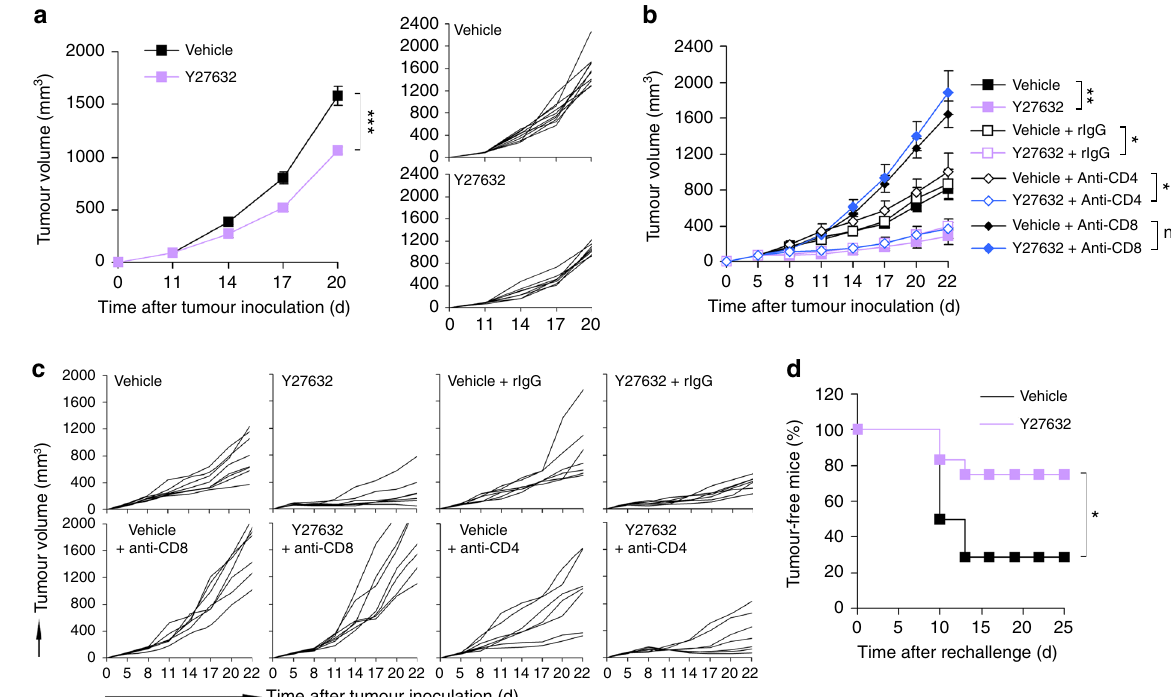
Fig. 3 ROCK blockade induces antitumour immunity. a CT26.CL25 tumour-bearing nude mice were injected (i.v.) with Y27632 (10 mg kg − 1 ) or vehicle. Tumour volume was measured at the indicated times. Data are presented as means ± s.e.m. (left panel) and tumour growth curves of individual mice (right panels) ( n = 8 – 10). b , c BALB/c mice were transplanted with CT26.CL25 cells and injected with Y27632 (10 mg kg − 1 ) at the indicated times, as described in Supplementary Fig. 6e. Five days after tumour inoculation, mice were injected (i.p.) with neutralizing anti-CD4 or anti-CD8 antibody. b Tumour volume was measured in each group at the indicated times. Data are presented as means ± s.e.m. and c tumour growth curves of individual mice ( n = 7 – 8). d CT26.CL25 tumour-bearing BALB/c mice were injected (i.v.) with Y27632 or vehicle. Twenty-two days after tumour inoculation, primary tumours were surgically removed from mice. Seven days later, a high dose of tumour cells (7 × 10 6 cells) was introduced into the contralateral fl ank, and the percentage of tumour-free mice was evaluated at the indicated times ( n = 12 – 14). * P < 0.05, ** P < 0.01, *** P < 0.001, ns, not signi fi cant; signi fi cance determined by unpaired Student ’ s t test ( a , b ) or log-rank test ( d